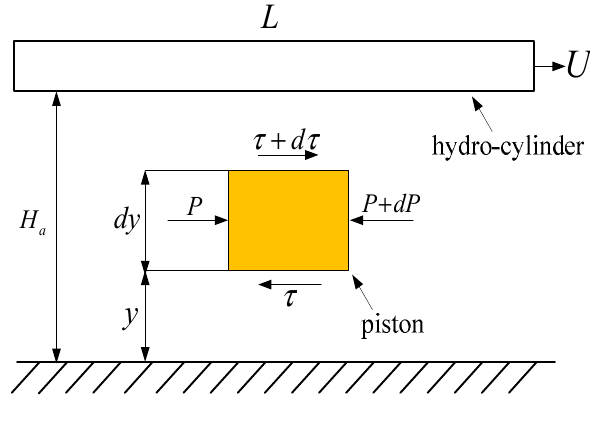
Figure 6. Friction model of the piston